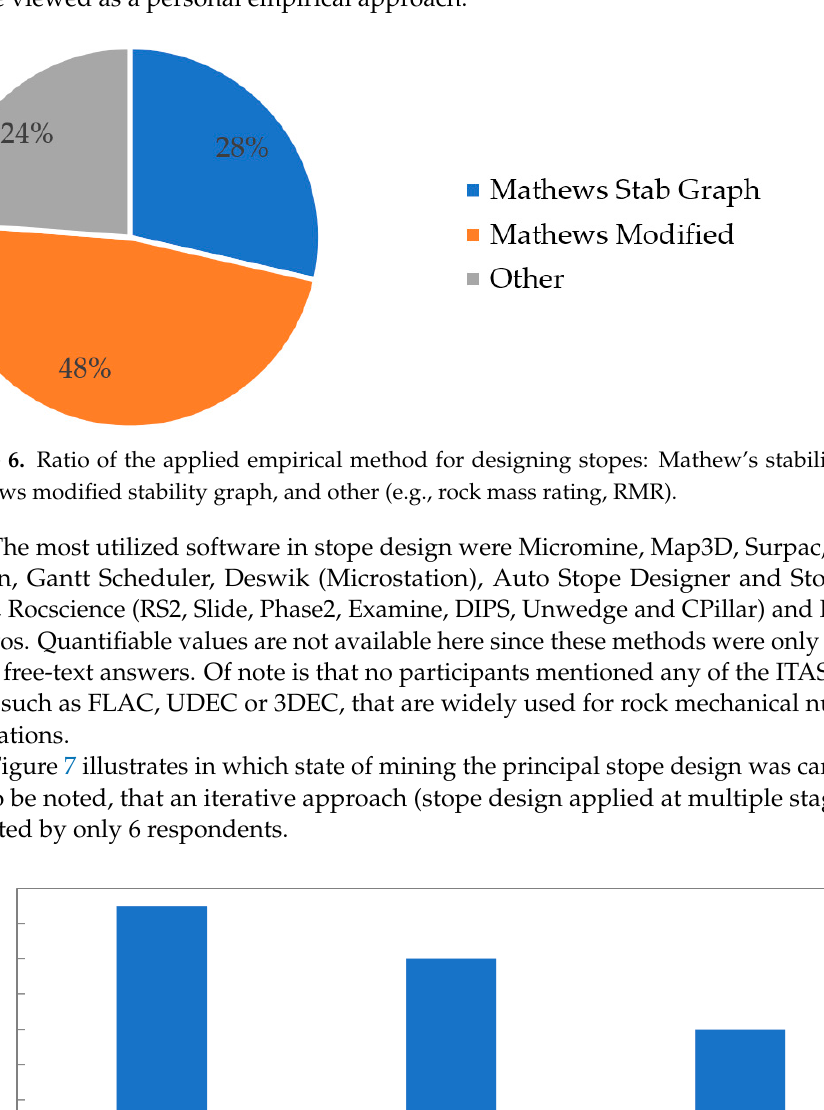
Figure 5. Ratio of the method that is used for design stopes in the mines.